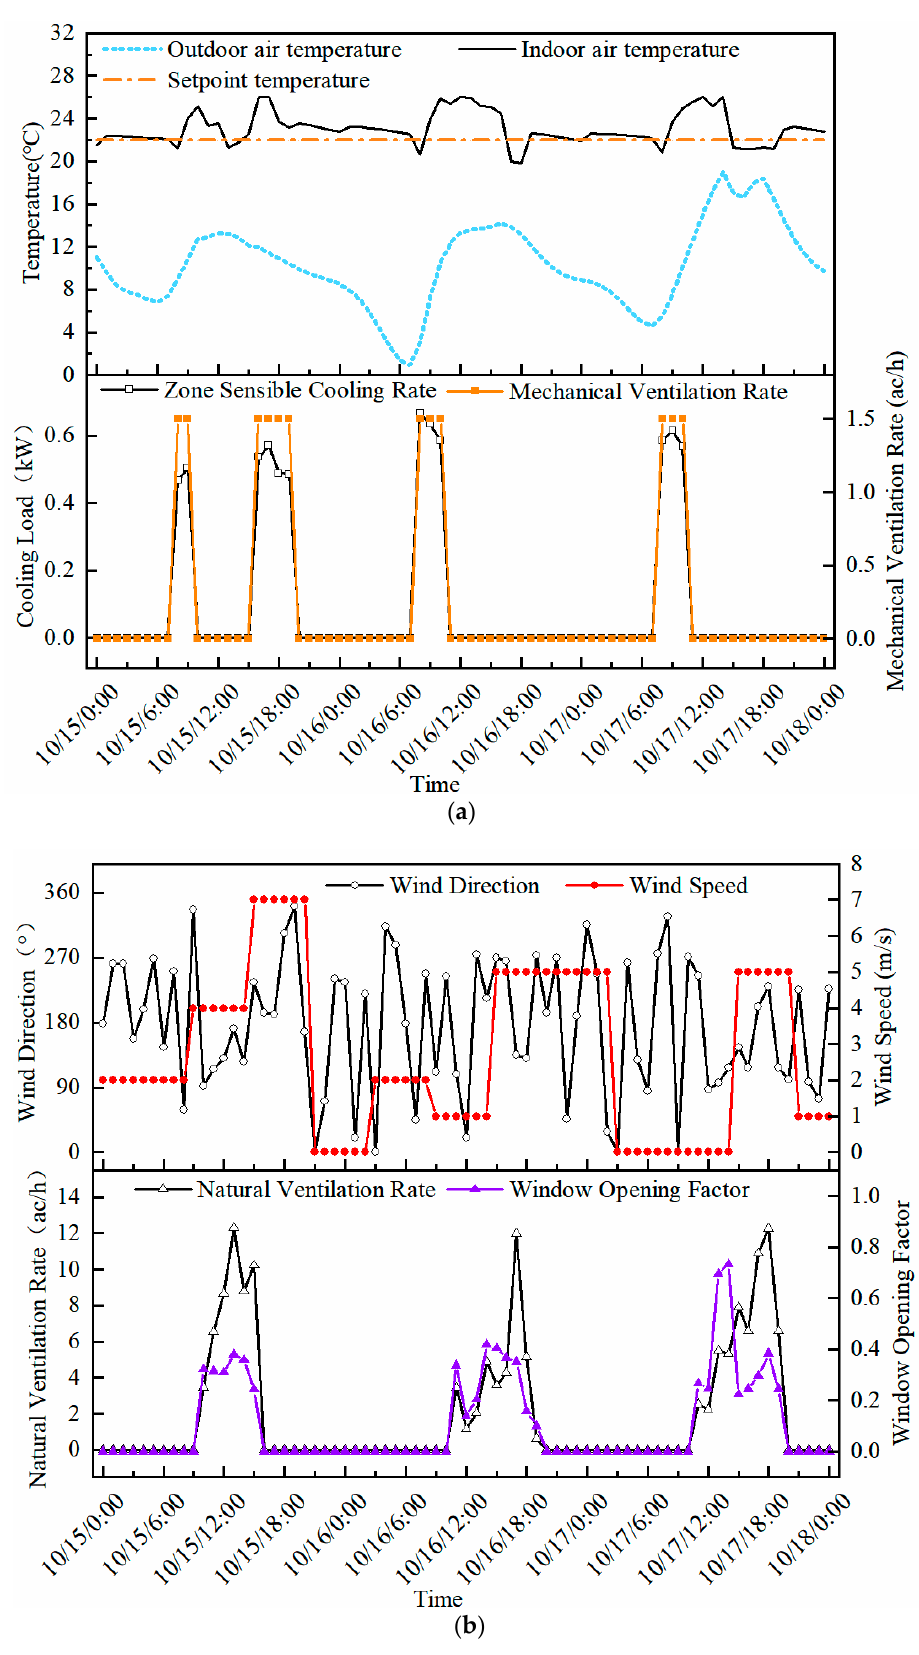
Figure 13. ( a ) Predicted space temperatures, cooling load and ( b ) airflow rates during 3 days in October (mechanical and natural ventilation mode).